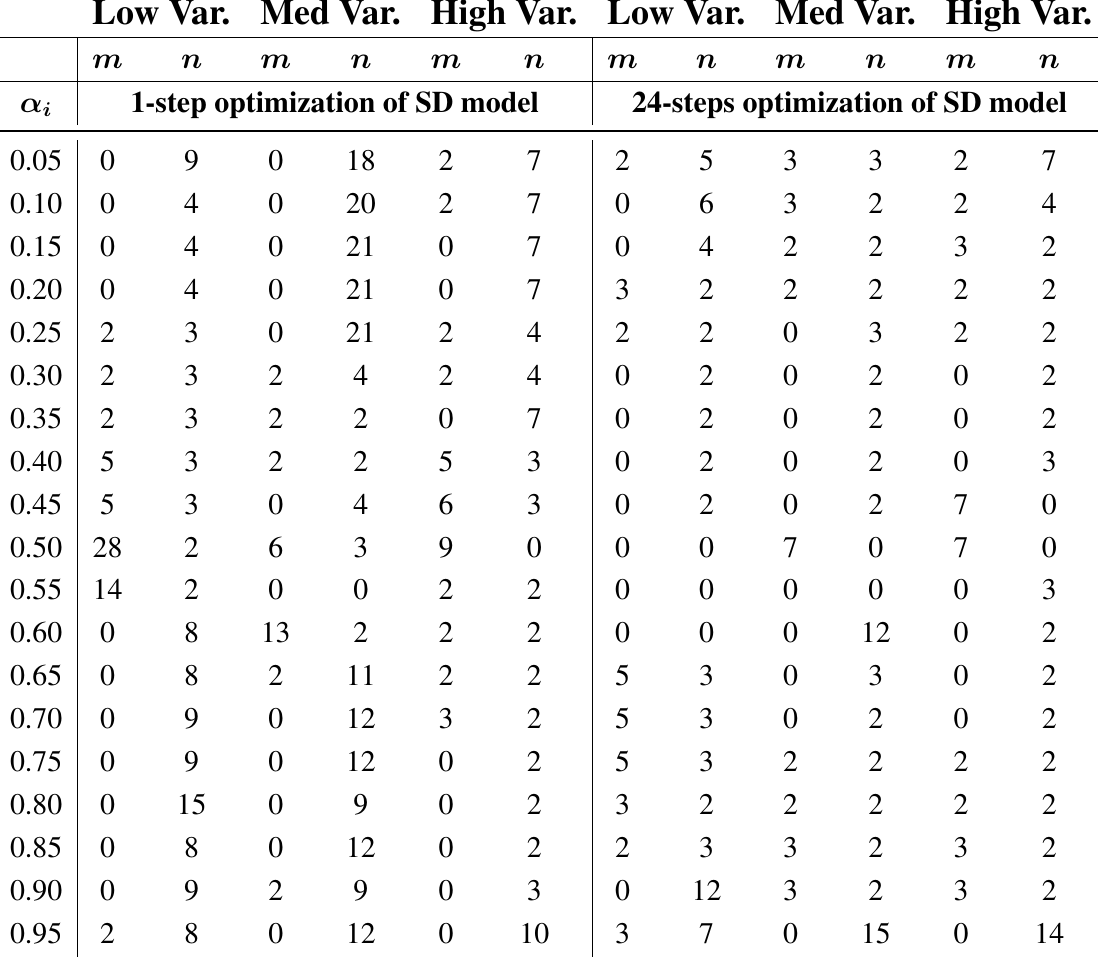
Table 3. 1-step and averaged over 24-steps CFS optimization results for the SD model of